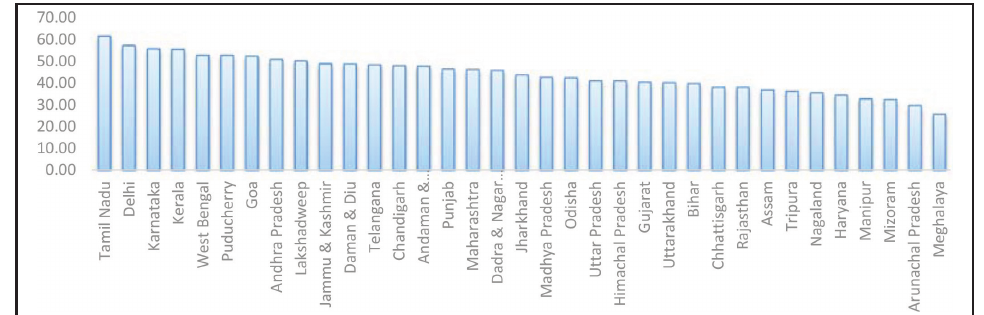
Figure 5 AI by age ≥50 years in India